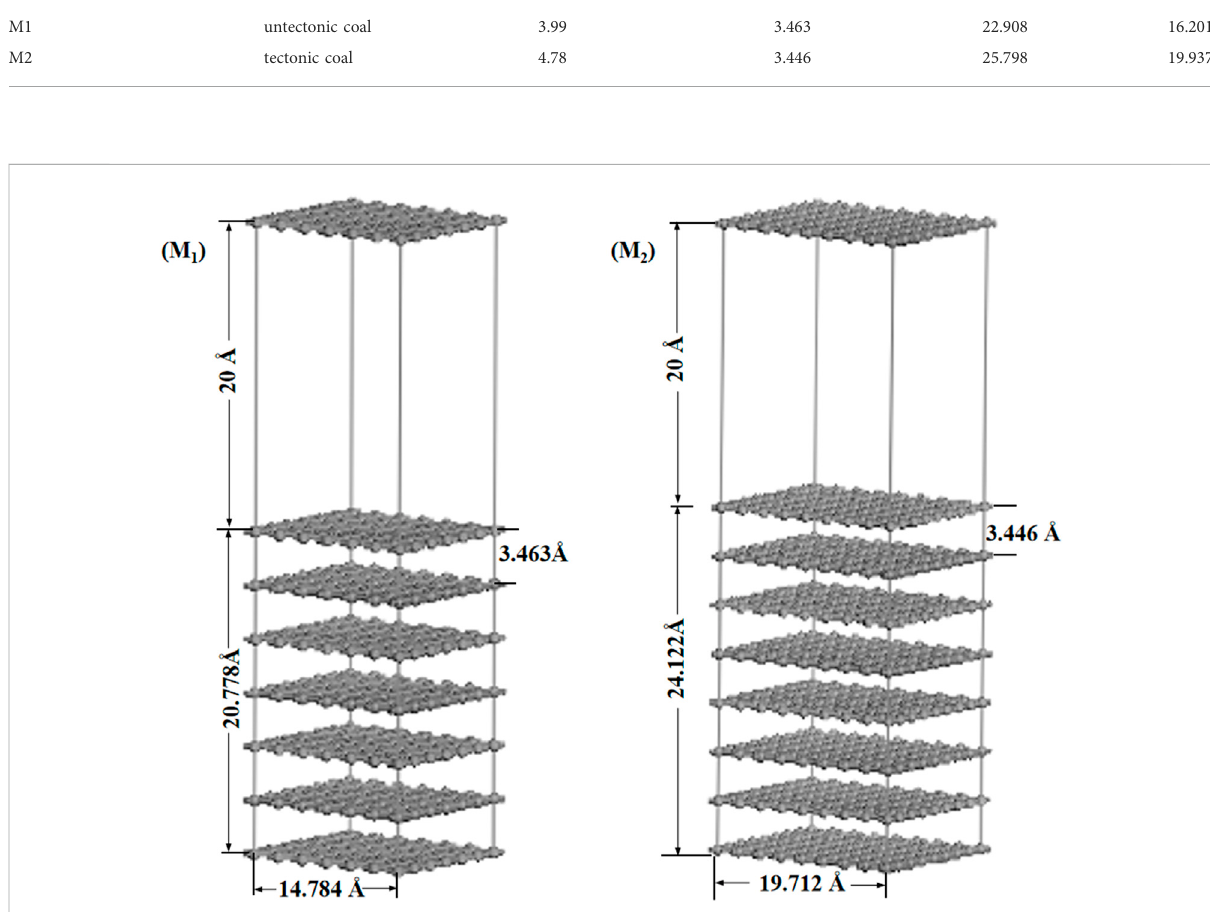
FIGURE 7 Models of untectonic anthractie coal (M 1 ) and anthractie tectonic coal (M 2 ) (modi fi ed from Jing et al., 2010).